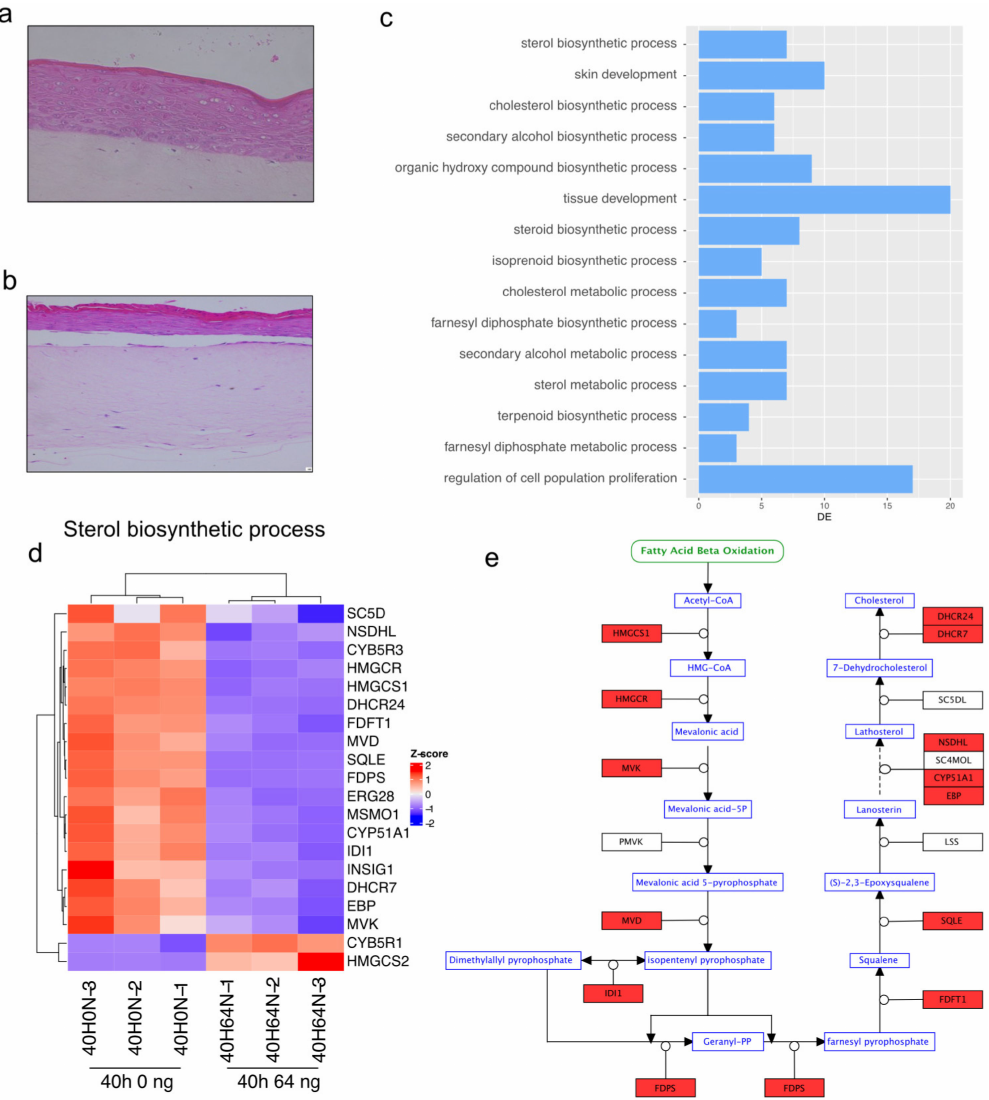
Figure 6. Effect of everolimus treatment for 40 h. ( a ) Hematoxylin and eosin (H and E) staining of an oral mucosa model after 40 h. ( b ) H and E staining of an oral mucosa tissue model treated with 64 ng/mL everolimus for 40 h. The magnification factor for ( a , b ) was 40 × . ( c ) GO enrichment analysis for biological processes of genes differentially expressed between untreated and tissue treated with 64 ng/mL everolimus for 40 h. Terms are ordered according to significance ( y -axis) and the number of differentially expressed genes in each process is shown on the x -axis. ( d ) Heatmap illustrating RNA-Seq differential expression for genes associated with the sterol biosynthetic process (GO:0016126, padj < 0.05). ( e ) Schematic representation of the cholesterol synthesis pathway with the genes that are downregulated after 40 h of treatment with everolimus in ( d ) in